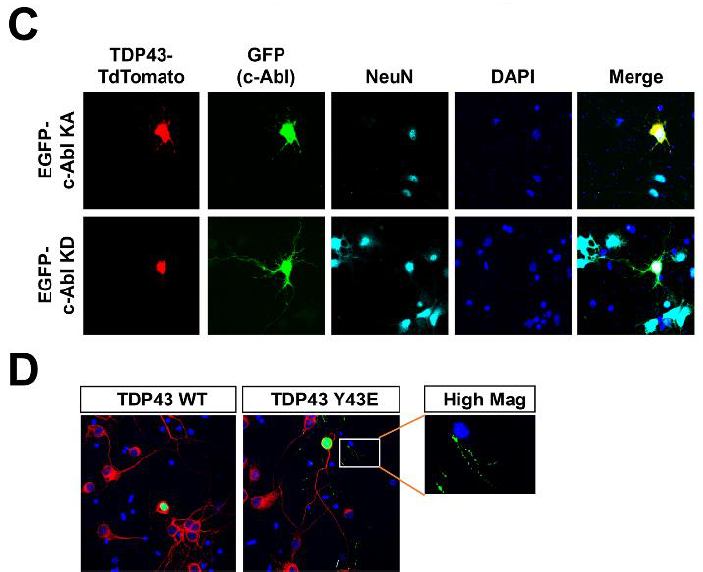
Figure 4. Y43 residue of TDP-43 associates with the TDP-43 pathology. ( A ) Immunostaining with G3BP1 antibody that can detect cytoplasmic stress granules in SH-SY5Y cells transfected with GFP- WT TDP-43, GFP-phospho-mimic forms of Y43E and Y155E TDP-43. ( B ) Quantification of the percentage of cells with cytoplasmic stress granules (n = 3). Statistical significance was determined by using one-way ANOVA with Tukey’s correction; * p < 0.05, n.s. = non-significance. ( C ) Increased localization of TDP-43 at neurite granules by c-Abl KA co-expression in cultured cortical neurons. TDP-43 TdTomato and EGFP-c-Abl were expressed in the cultured cortical neurons and followed by immunocytochemistry. ( D ) Phospho-mimic form of TDP-43 Y43E showed increased neurite granule expression than TDP-43 WT in primary cultured cortical neurons. EGFP-TDP-43 WT and Y43E were expressed alone in the cultured cortical neurons and followed by immunocytochemical